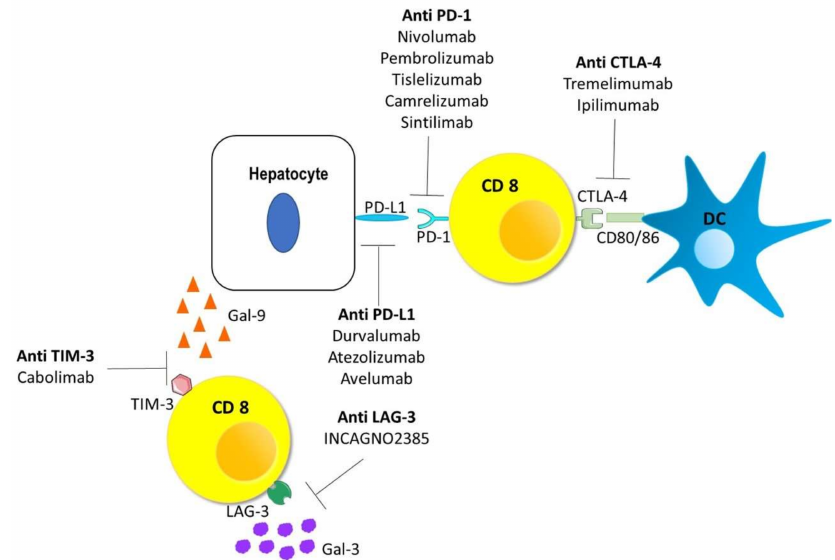
Figure 3. Schematic diagram of immune checkpoint expressions and their inhibitors.